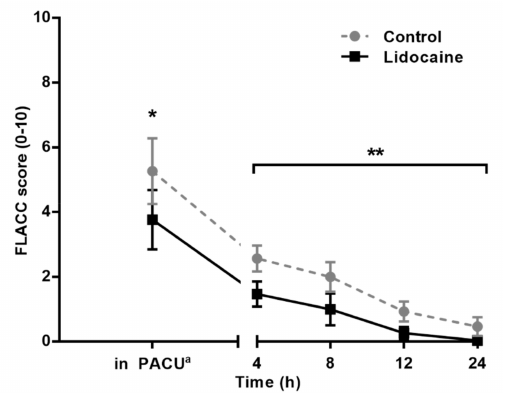
Figure 2. Face, legs, activity, crying, consolability (FLACC) scores in the PACU and in the ward. Values are shown as mean, and the bars indicate the 95% confidence interval for the mean. * p = 0.017. ** Bonferroni corrected p = 0.010. a The highest FLACC score in